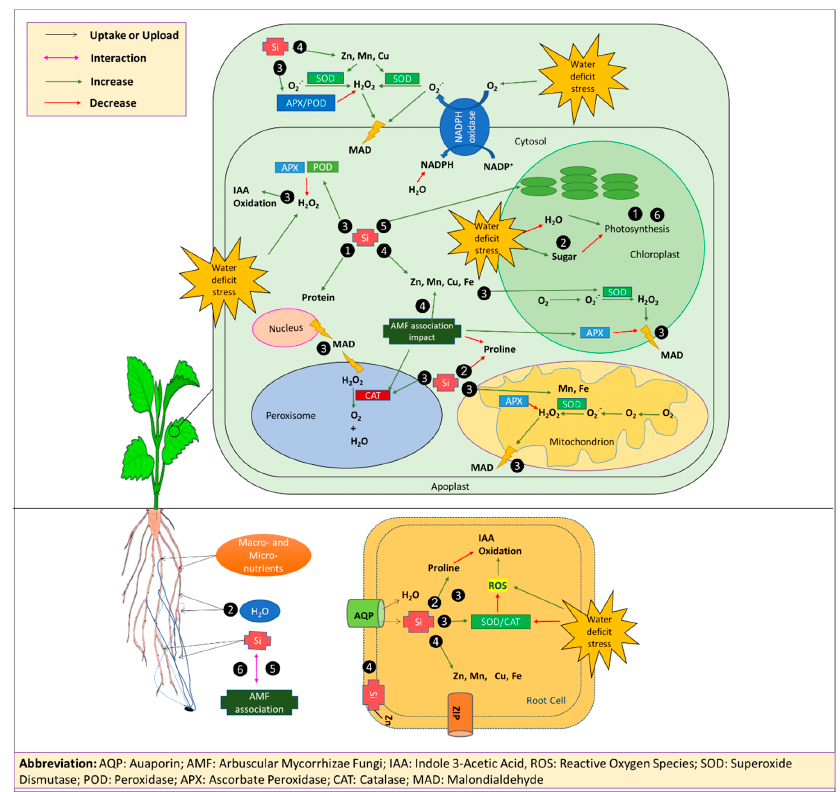
Figure 3. A conceptual model representing the effect of Si and AMF in drought-stressed strawberry plants reverting plant performance to well-watered conditions. Si and AMF 1) enhanced growth and photosynthesis of plants, 2) regulated the water status and concentration of organic osmolytes, 3) promoted the antioxidative defense system, 4) increased plants nutrients uptake, 5) had synergistic effects, and 6) enhanced plant growth even in the absence of stress. Abbreviations: AQP: Aquaporin, AMF: Arbuscular Mycorrhizae Fungi, IAA: Indole 3-Acetic Acid, ROS: Reactive Oxygen Species,